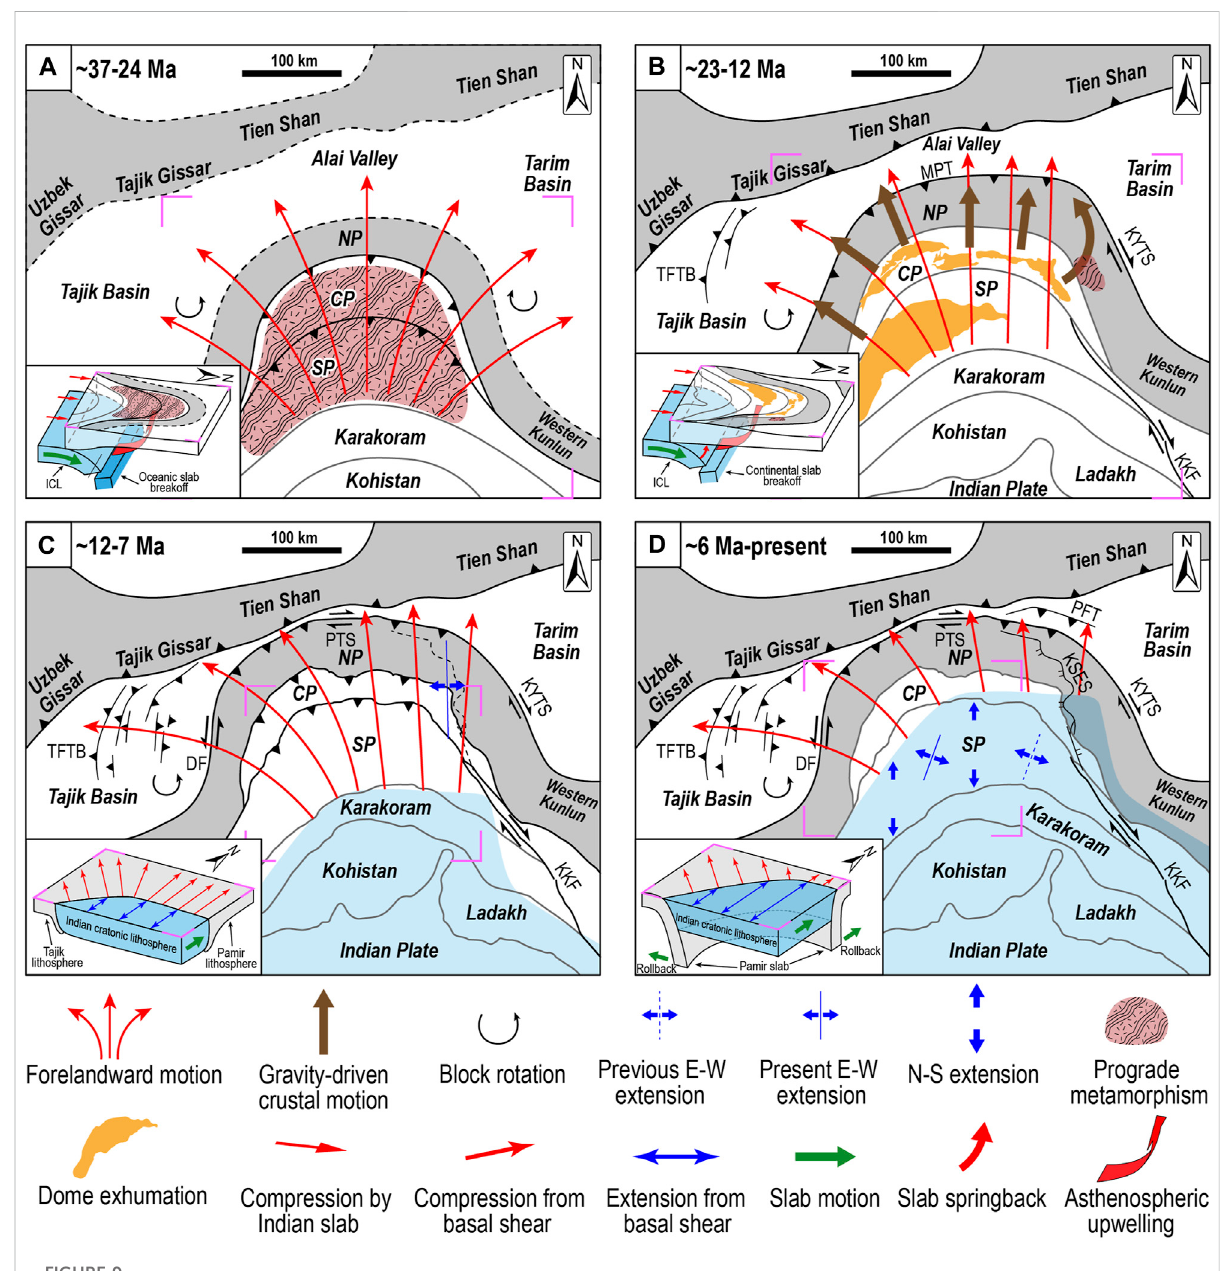
FIGURE 9 Tectonic evolution and associated geodynamic processes of the Pamir salient since the Middle – Late Cenozoic. Insets show schematic diagrams of geodynamic processes within pink boxes in corresponding plane graphs, based on Stearns et al. (2015), Kufner et al. (2016), and Rutte et al. (2017b). Insets in Figures (C,D) illustrate interactions between the Indian mantle lithosphere (blue-shaded polygons in plane graphs) and the Pamir slab. (A) ~37 – 24 Ma: after the breakoff of the Neo-Tethyan oceanic lithosphere, the subduction of the buoyant Indian continental lithosphere(ICL)pushedthePamirsalientnorthwardviaradialthrusting,causingblockrotationsintheTarimandTajikbasins;thecrustintheCentral Pamir (CP) and South Pamir (SP) experienced intense thickening and prograde metamorphism. (B) ~23 – 12 Ma: the breakoff of the ICL caused asthenosphericupwellingandspring-backoftheremainder,inducingthegravitationalcollapseintheCPandSP;themovementofthegravity-driven upper crust causedthe migration of the deformation front to the North Pamir (NP) and kinematictransformation in the eastern Pamir into the large- scale dextral slip. (C) ~12 – 7 Ma: the stress effects of basal shear imposed by the underthrusting of the cratonic ICL have governed the kinematics of the Pamir salient since ~12 Ma; due to impedance of the rigid Tarim block in the east and the irregular shape of the Indian promontory, the compressioninducedbybasalshearfacilitatedtheforeland-wardexpansionofthePamirbyasymmetricradialthrusting,generating~E – Wextension in the northeastern Pamir that formed the KSES. (D) During ~6 Ma – present: as the underthrusting continued, the earlier distributed deformation concentratedinthenorthernmarginandpropagatednorthward,forming thePFT;theextensionresultingfrombasal shearandrollback ofthePamir slab also began to affect the SP, showing westward migration of the E – W extension. Fault names same as Figure